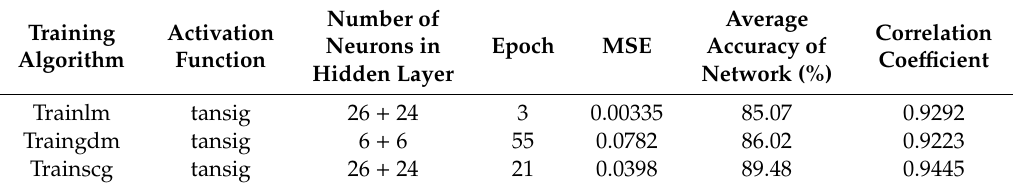
Figure 9. Network regression chart for the (a) training, (b) evaluation, (c) testing, and (d) overall stages. Table 4. Networks designed using three training algorithms with an optimal number of neurons in the hidden